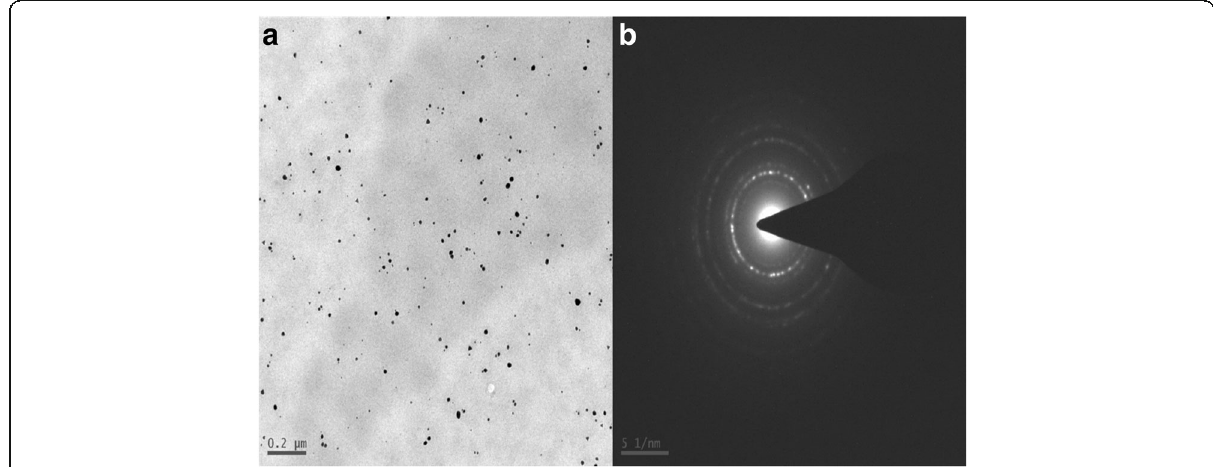
Fig. 6 ( a ) TEM image ( b ) corresponding SAED pattern of papaya leaf extract capped gold